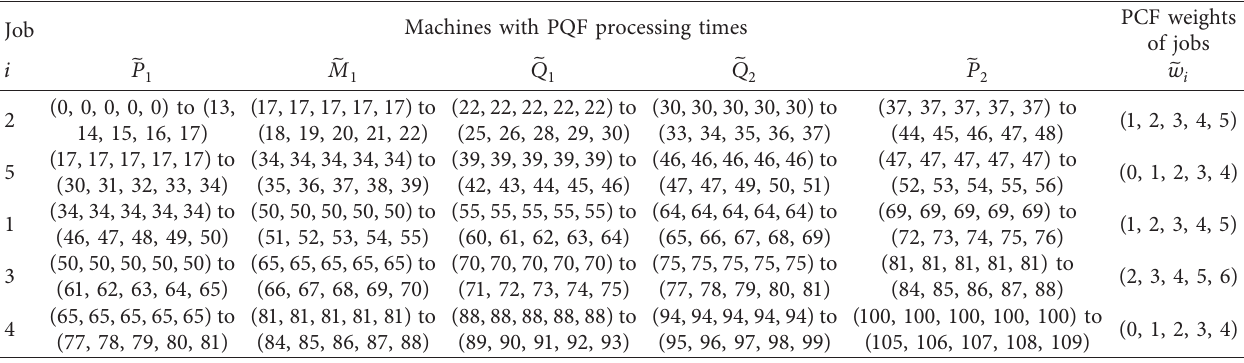
Table 7: Piecewise quadratic fuzzy elapsed time.